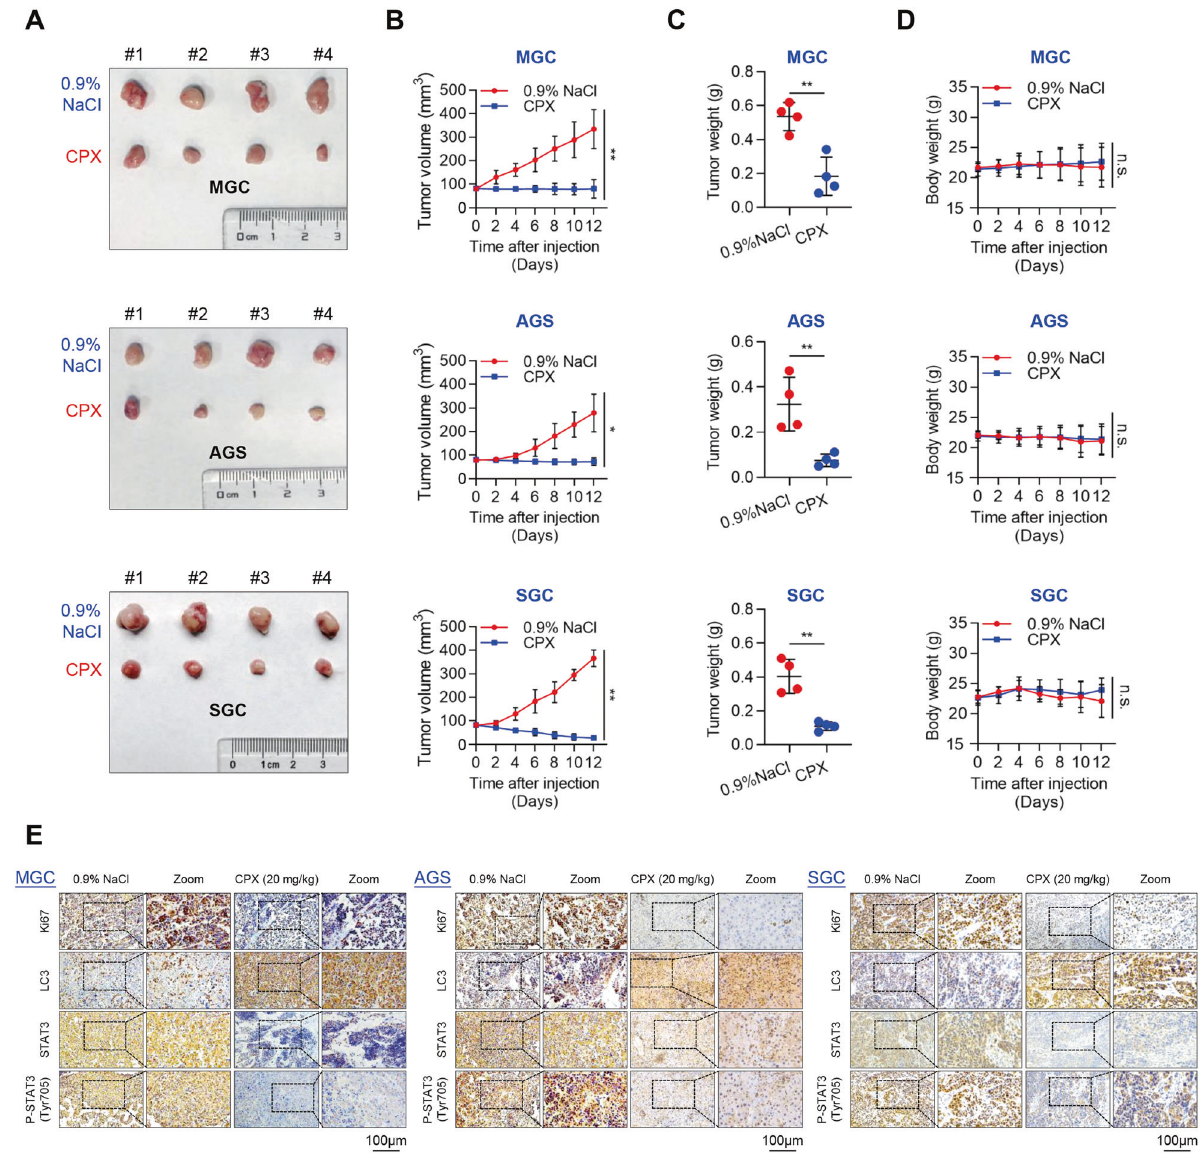
Fig. 6 CPX inhibits tumor growth in a mouse xenograft model of GC. A – D Tumor-bearing nude mice of MGC, AGS, and SGC cells (4 mice per group) were intraperitoneally injected with 0.9% NaCl or CPX (20 mg/kg), respectively. Images of dissected tumors from tumor-bearing mice were shown ( A ). Tumor volume was measured once in 2 days ( B ). Tumor weight was measured after 12 days of consecutive injections ( C ). Changes in the mean body weight from mice treated with 0.9% NaCl or CPX ( D ). Data were shown as mean ± SD ( n = 4, * P < 0.05, ** P < 0.01,